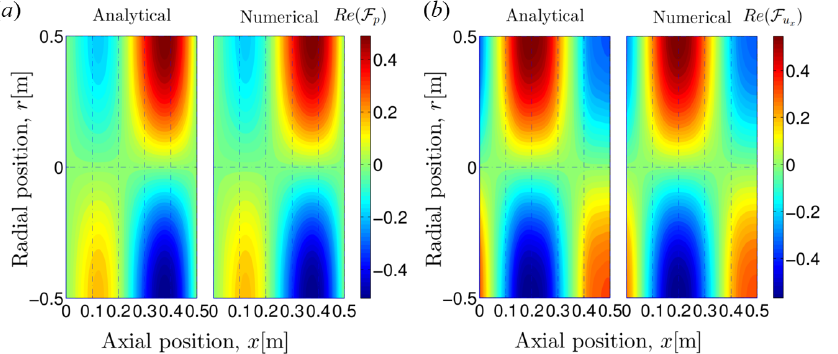
Figure 2. 1T mode: Contour comparisons for the real part of ( a ) pressure F p and ( b ) axial velocity